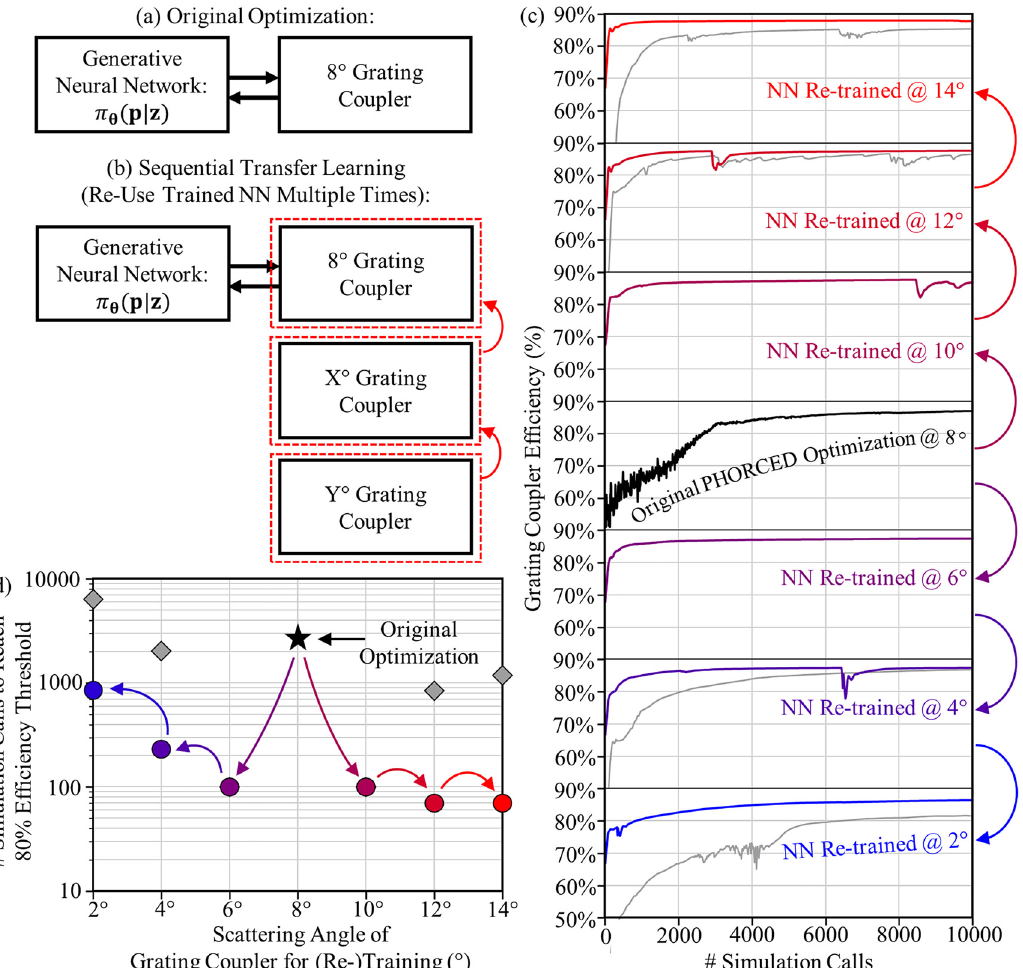
Figure 4: Transfer learning applied sequentially improves convergence for grating coupler scattering angles that are distant relative to the original optimization’s scattering angle. The original PHORCED optimization from Figure 2(b) is qualitatively depicted in (a) for comparison with the ‘‘sequential’’ transfer learning approach in (b). Here, we sequentially re-train the neural network (originally trained to generate 8 ◦ grating couplers) with progressively different scattering angles, with the intention of slowly changing the physics seen by the neural network. Grating coupler efficiency as a function of the number of simulation calls for each of the retraining sessions are shown in the blue/red curves of (c), where the arrows on the right-hand side show the sequence of each application of transfer learning. The results of the one-shot (non-sequential) transfer learning approach from Figure 3(c) are shown in gray for comparison. In (d) we plot the number of simulation calls needed for the grating coupler optimizations from (c) to reach an 80% efficiency using the sequential transfer learning approach, similar to the corresponding plot in Figure 3(d) . The blue/red arrows and dots indicate applications of sequential transfer learning, and the gray diamonds correspond to non-sequential transfer learning